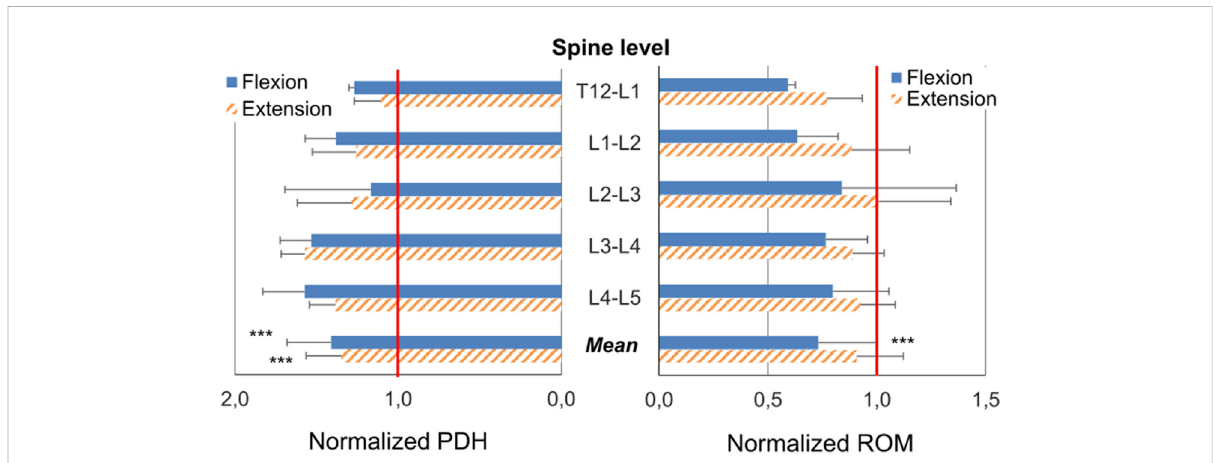
FIGURE 4 Changes (Mean ± SD) of the posterior disc height (PDH) and of the Range of Motion (ROM) caused by cement discoplasty at the different spine levels and as an average ofall levels. The PDH andROM after discoplastywerenormalized withrespect to thevaluebefore discoplasty:anormalized value of 1.00 indicates no change; a value greater (smaller) than 1.00 indicates that the respective magnitude was increased (decreased) due to discoplasty. First quartile, median and third quartile are represented by lines. Mean is indicated by the cross and min and max values by the whiskers. Statistical signi fi cance (paired t -test, p < 0.001) is designated by ***.